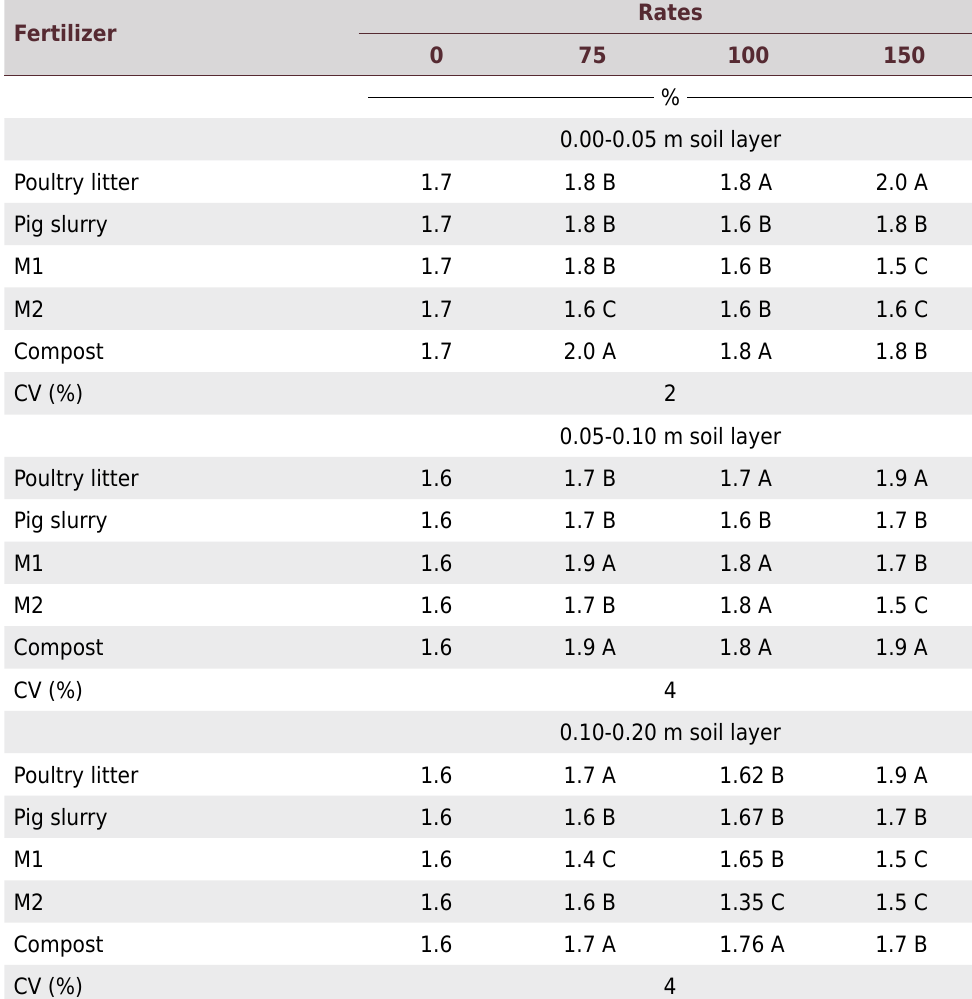
Table 3. Geometric mean diameter (mm) of aggregates from a Rhodic Kandiudox, in the layers of 0.00-0.05, 0.05-0.10 and 0.10-0.20 m after seven years of application of types and rates (%) of organic and mineral